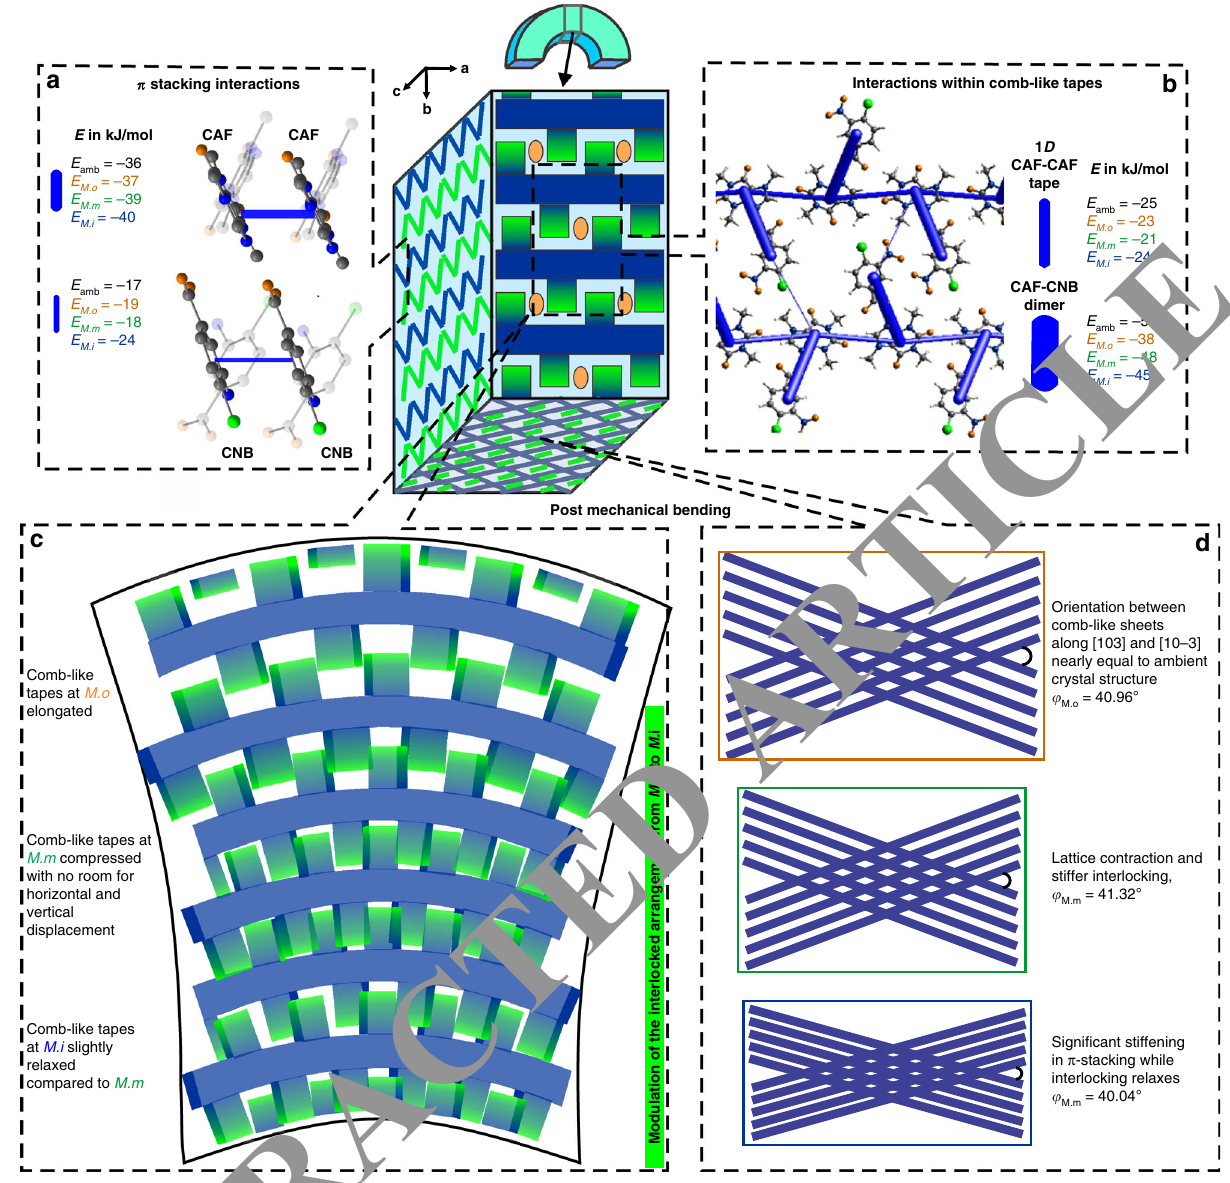
Fig. 5 Schematic description of structural changes. Total interaction energies a related to π -stacking between pairs of CAF – CAF and CNB – CNB, and b among molecules within comb-like 1D tapes in ambient and regions of M . c Schematic representation of the strained interlocked tapes depicting elongation, compression and slight relaxation at regions of M of bent crystal viewed along [001] direction. d Changes in stacking and the angle among tapes. Solvent molecules are omitted for = O is blue-shifted (Fig. 4f), showing traits intermediate to (CNB) C the ambient and M regions.